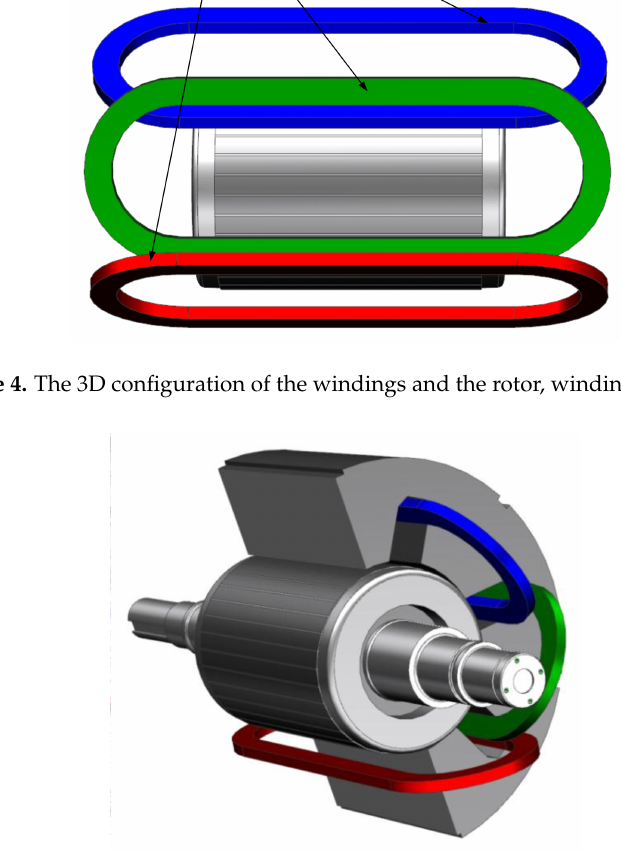
Figure 5. The 3D configuration of the windings and the rotor, winding end